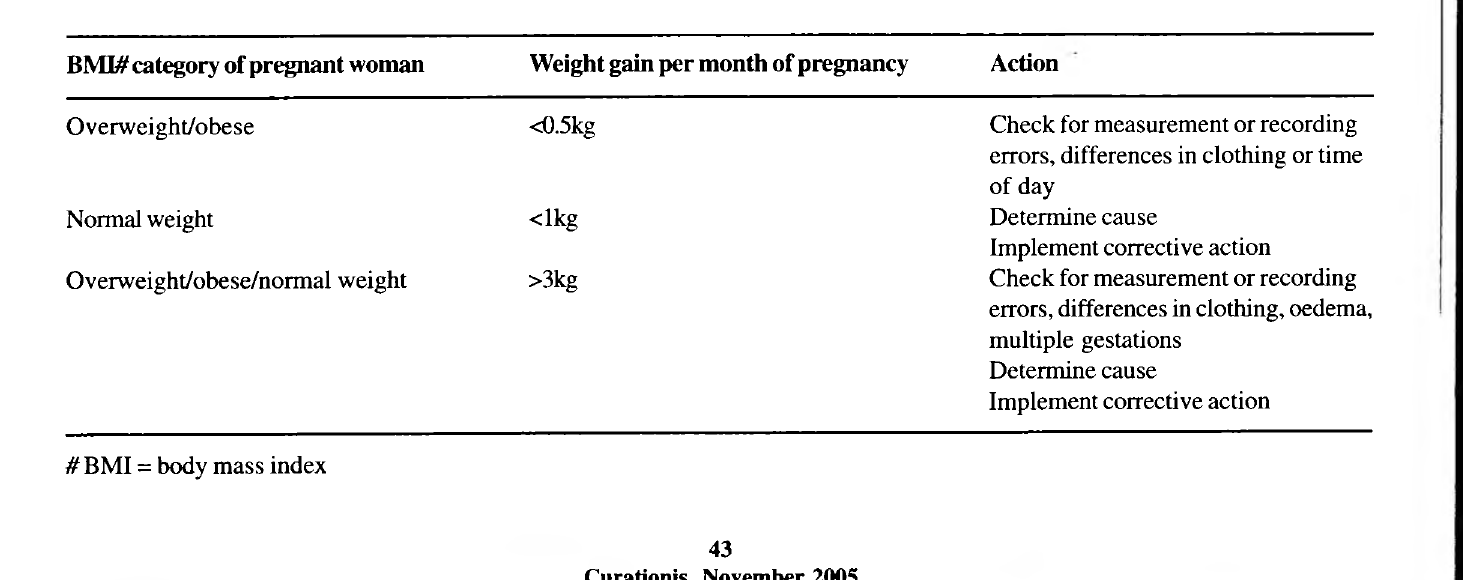
Table 2 Gestational weight gain cut-off points showing deviations from the expected weight gain